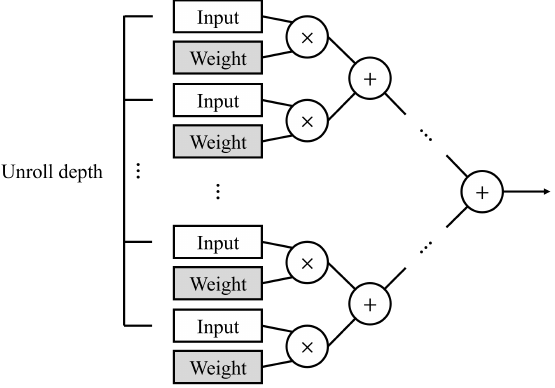
Figure 7. Unrolled arithmetic